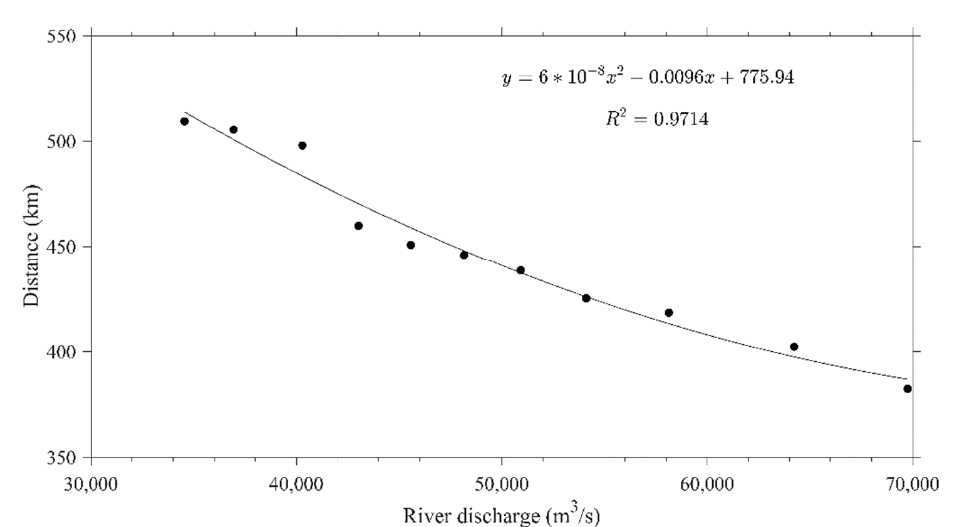
Figure 9. Relationship between the tidal level limit and river discharge in the Changjiang River’s estuary during the flood season.